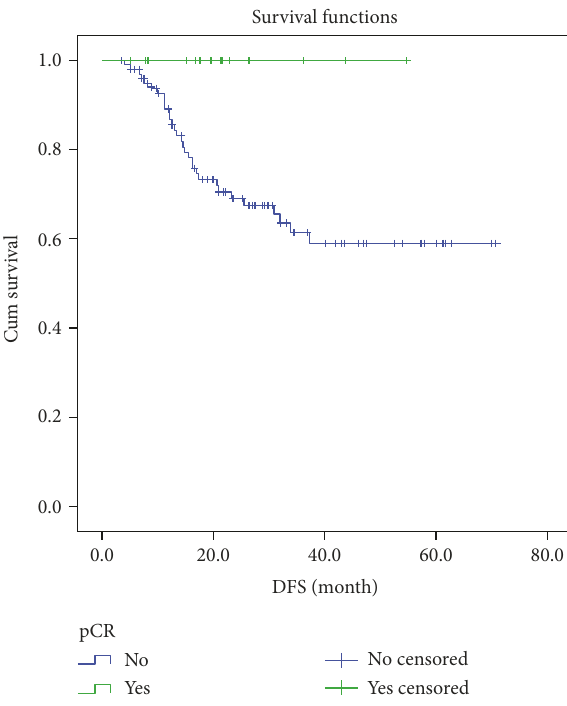
Figure 2: Kaplan-Meier 3-year DFS estimation in HR + and HR −